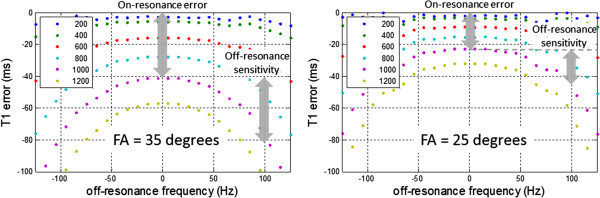
Simulated off-resonance response of MOLLI for 5s(3s)3s protocol with TR = 2.8 ms using FA = 35 (left) and 25 (right) at various T1’s for myocardial T2 = 45 ms. Using a lower flip angle (FA) trades SNR (precision) for improved accuracy and reduced off-resonance sensitivity. For T1 = 1000 ms, sensitivity to off-resonance over ±100 Hz is 40 ms and 25 ms for FA = 35° and 20°, respectively.